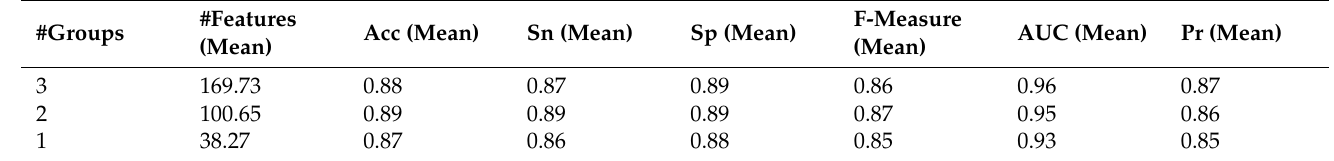
Table 4. Performance results of AMP-GSM approach for the Gram-negative dataset of Dataset 1 without using physico-chemical properties (for 11 groups and 100-fold MCCV) *.